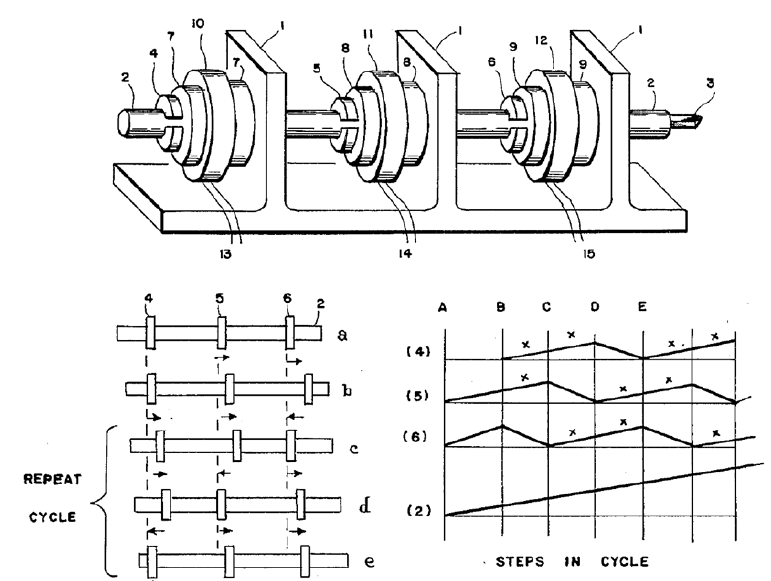
Figure 5. Precision positioning device proposed by Stibitz in 1962, which could be considered as the first structure functioning according to piezo-walk and inertia-drive principles [11].